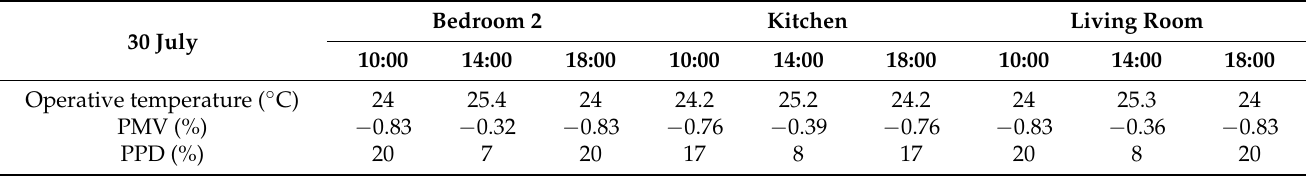
Table 10. PMV and PPD values calculated on 30